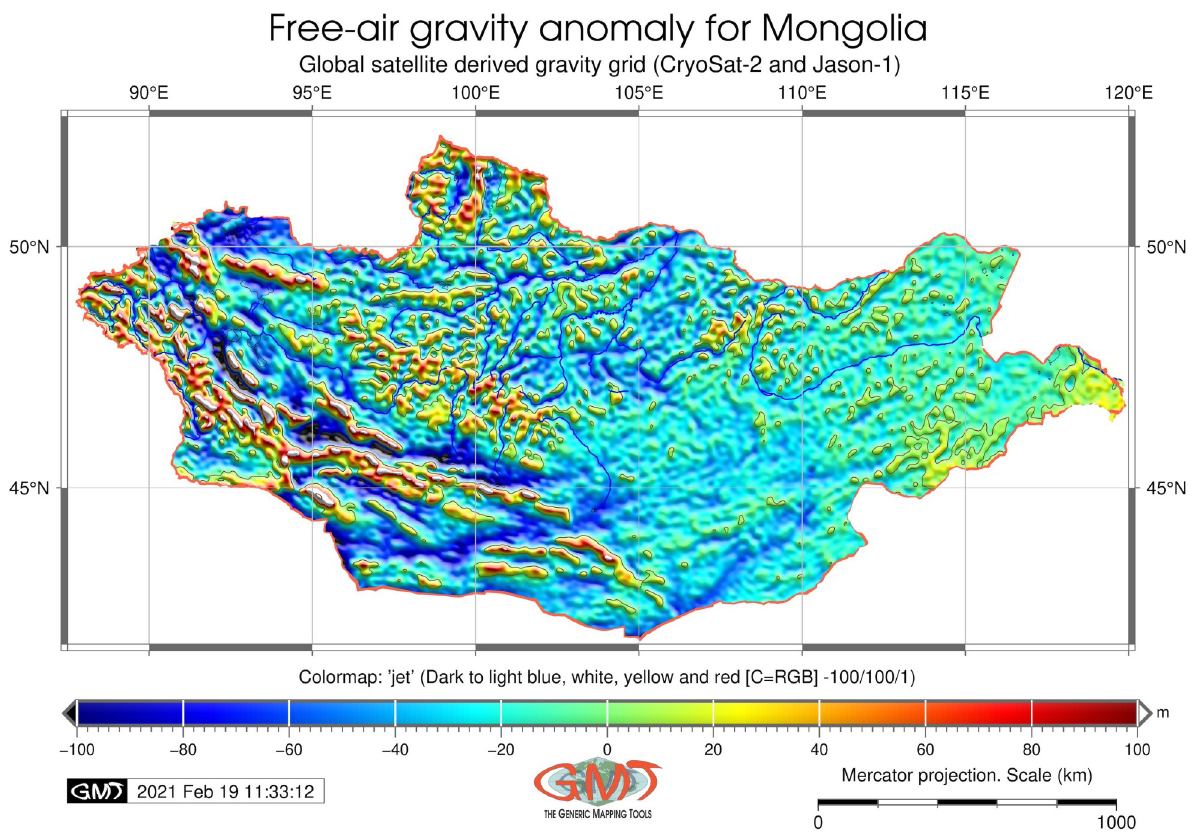
Fig. 4. Free-air gravity anomaly (Faye’s corrections) over the region of Mongolia (41.5°N to 52.5°N to 87.5°E to 120°E) demonstrates the strength of the Earth’s gravity minus the gravitational effect of an Earth approximating ellipsoid and the effect of topography relative to the topographic elevations at each pixel of the grid according to the resolution (1 arc-minute grid, based on the EGM-2008 dataset). Mapping: GMT. Source: